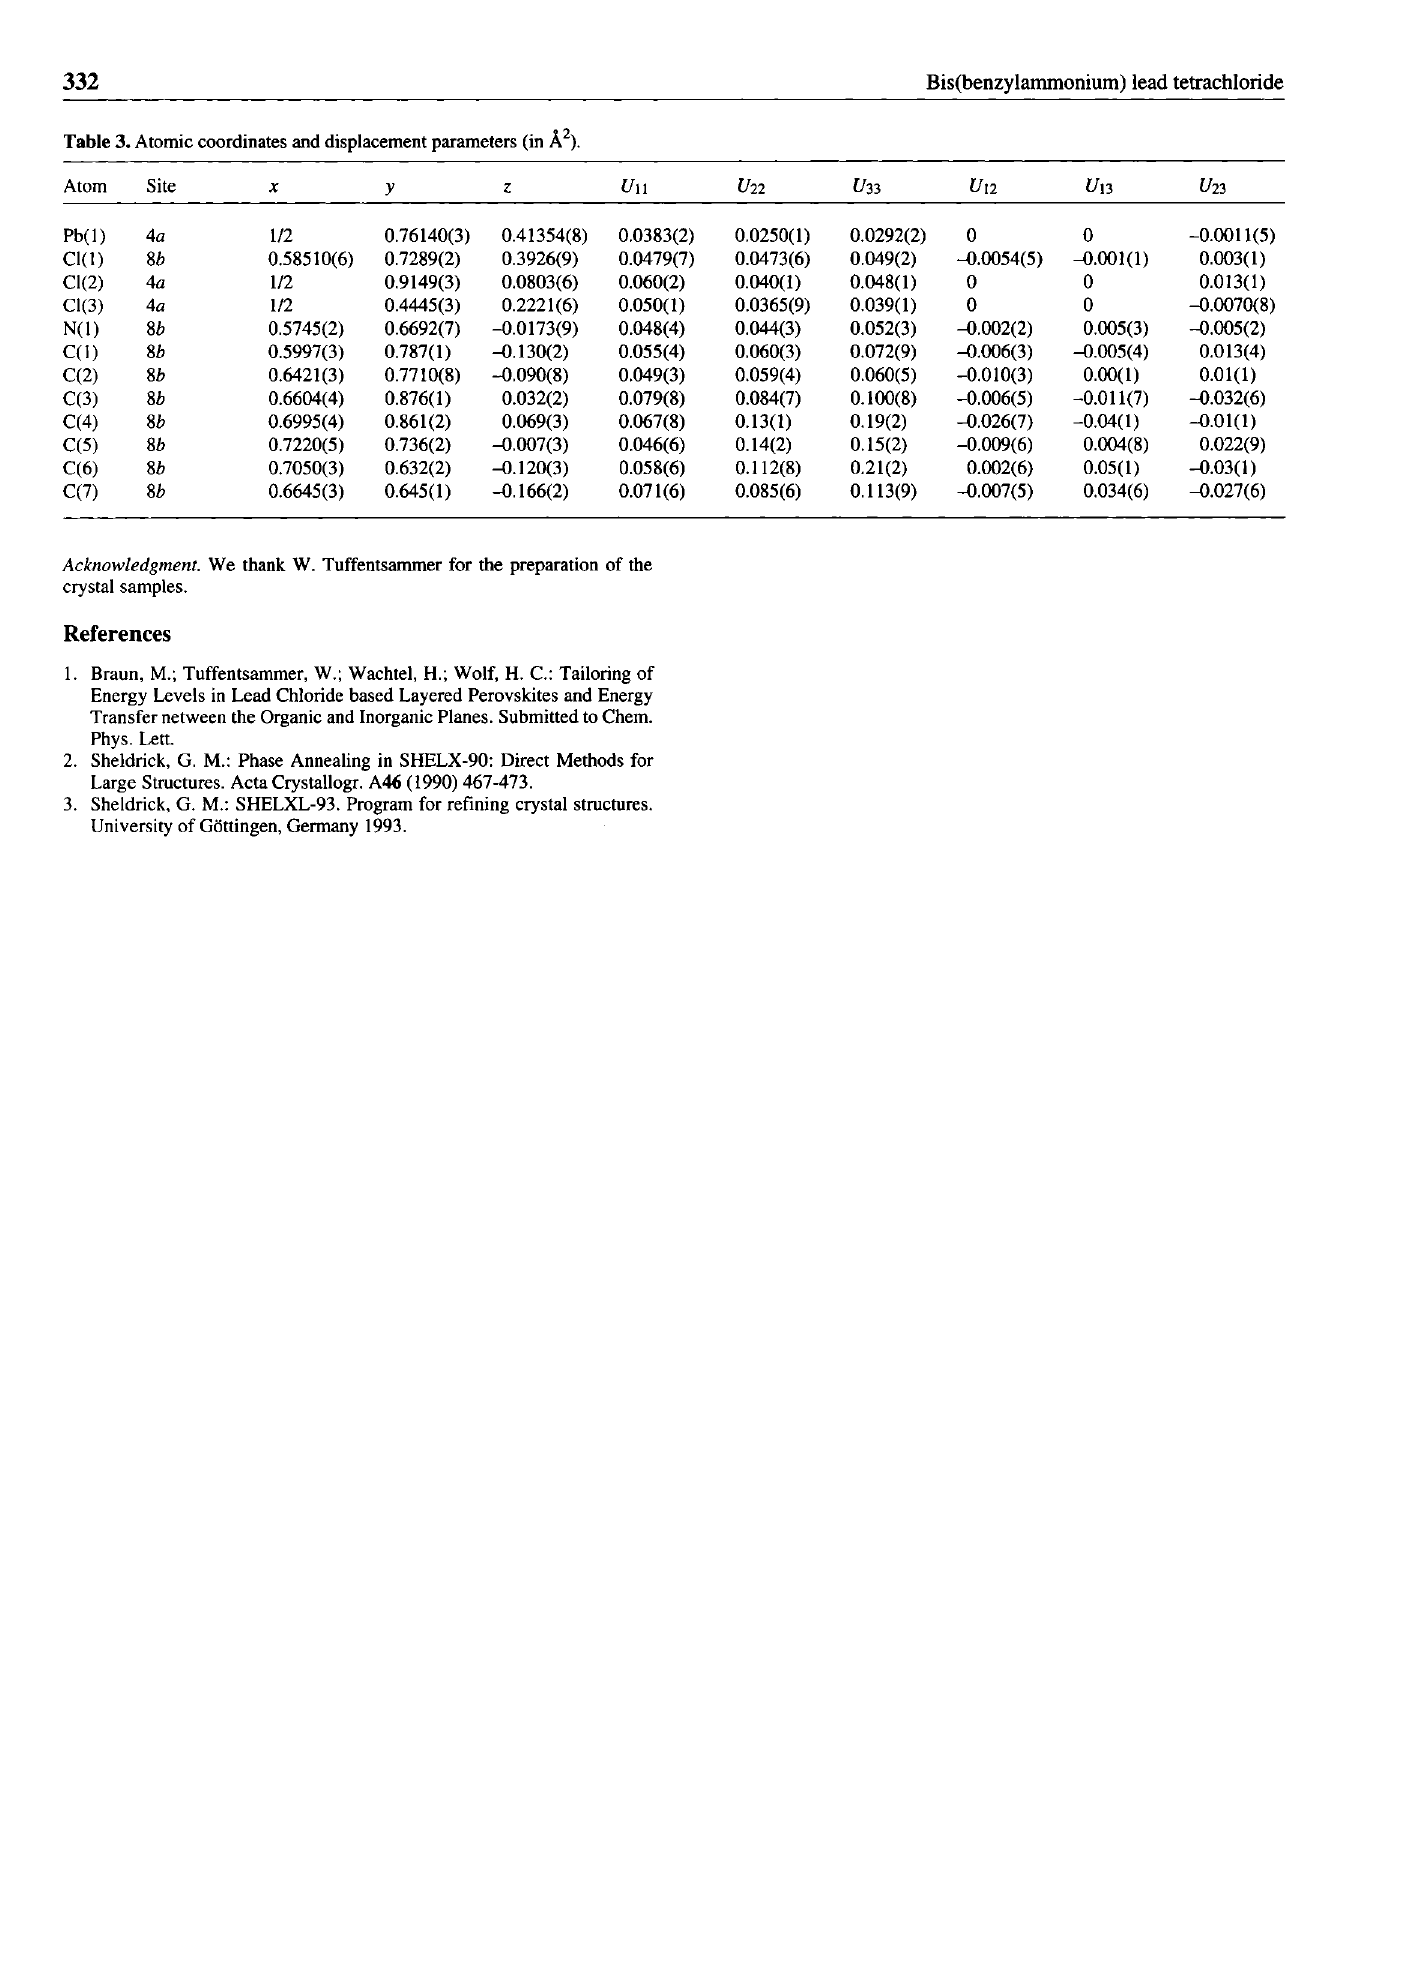
Table 3. Atomic coordinates and displacement parameters (in Â 2